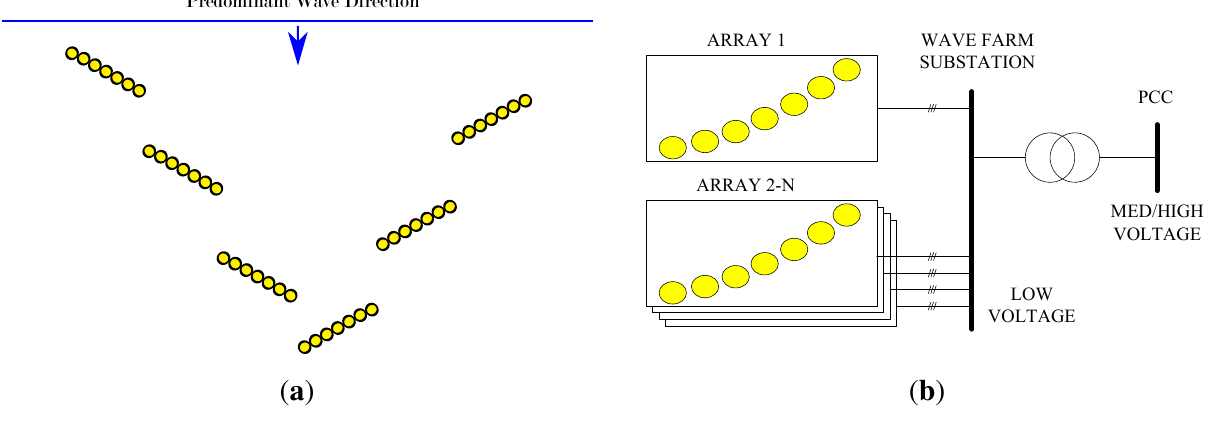
Figure 9. Wave farm design. ( a ) Farm configuration; ( b ) Electrical